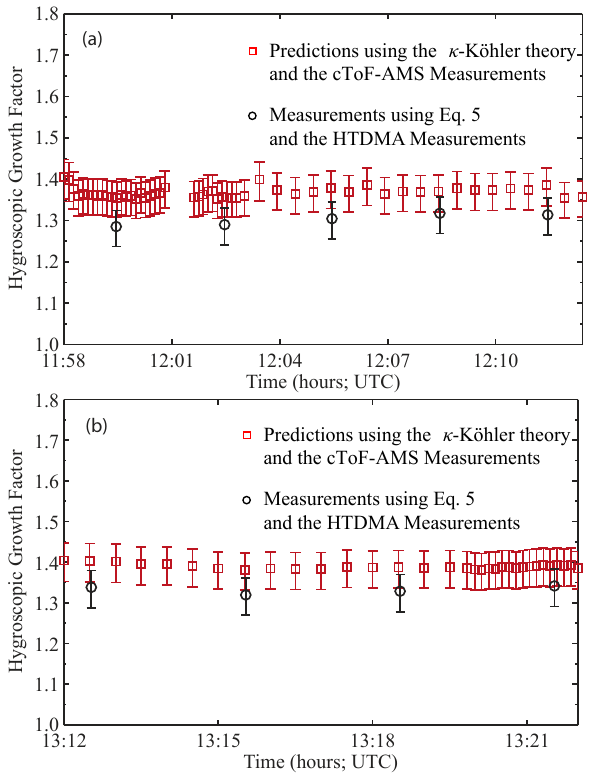
Fig. 6. Hygroscopic growth factors measured by the HTDMA (black dots) and predicted by κ -Köhler theory using the chemi- cal composition measurements from the airborne cToF-AMS (red squares) when the aircraft was flying close to Vigla station on 1 (flight b637) September 2011 (a) and on 4 (flight b641) (b) Septem- ber 2011. The HTDMA growth factors correspond to particles hav- ing dry mobility diameter of 100nm, whereas the chemical compo- sition corresponds to particles having Vacuum Aerodynamic Diam- eters (VADs) in the range 50–700nm. Error bars represent the 2% uncertainty in the RH